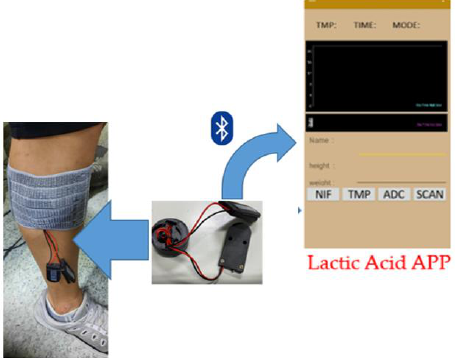
Figure 1. After installation of the continuous lactate sensor under the skin, the Bluetooth function is used to display the lactate data in a specially developed app. 2. Materials and Methods The sensor developed herein uses a circuit board with a sensing function and cyclic voltammetry to obtain measurements from a three-electrode electrochemical sensor. The three electrodes are the working electrode, reference electrode, and counter electrode. First, the circuit board is connected to the percutaneous microneedle of the three- electrode electrochemical sensor, which is attached to a patch and then penetrated under the skin to measure the lactate concentration in the subcutaneous tissue fluid. The meas- ured lactate concentration is transmitted to a smartphone app through the Bluetooth mod- ule on the circuit board and displayed so that the user can observe their own lactate value over time. The value displayed on the mobile phone is synchronized to the cloud to facil- itate data collection and analysis. In what follows, we describe the mechanism of the developed sensor, film formation on the percutaneous microneedle, and design of the microneedle array. 2.1. Introduction to Sensor Development and Instrumentation This section introduces the development and rationale of the sensor, as well as the chemistry used therein. The chemical materials used in this study are as follows: polyan- iline (RichHealth Technology Corporation, Hsinchu, Taiwan), Nafion (Uni-Onward Corp., New Taipei City, Taiwan), poly(2-hydroxyethyl methacrylate) (poly-HEMA) (Uni- Onward Corp.), phosphate buffer (PB) (Uni-Onward Corp) (pH = 7.2), l-lactic acid (FunYen Technology, Inc. Hsinchu, Taiwan), and lactate oxidase (Toyobo, Japan). 2.1.1. Range of Lactate Concentration in Human Body The main energy sources fueling human exercise are aerobic and anaerobic metabo- lism. The process of metabolism produces lactate and hydrogen ions. If the lactate and hydrogen ion decomposition rate of the body is slower than their production rates in the metabolic system, lactate and hydrogen ions accumulate, causing muscle soreness and fatigue. The value of lactate in the blood of a normal person without exercise is approximately 0.5 – 2 mmol/L [13]. In the experiment conducted herein, the target sample for measurement